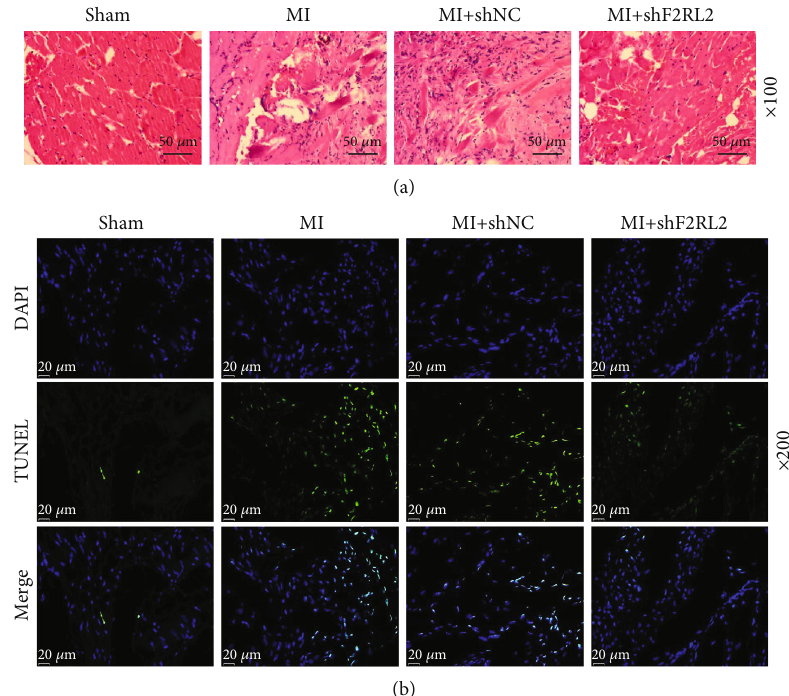
Figure 3: F2RL2 downregulation mitigated the cell apoptosis in myocardial tissues of MI mice. (a) The pathological changes of mouse myocardial tissues were detected using hematoxylin-eosin staining (magni fi cation × 100). (b) The cell apoptosis in myocardial tissues was evaluated using TUNEL staining (magni fi cation × 200). (F2RL2: coagulation factor II thrombin receptor like 2; MI: myocardial infarction).